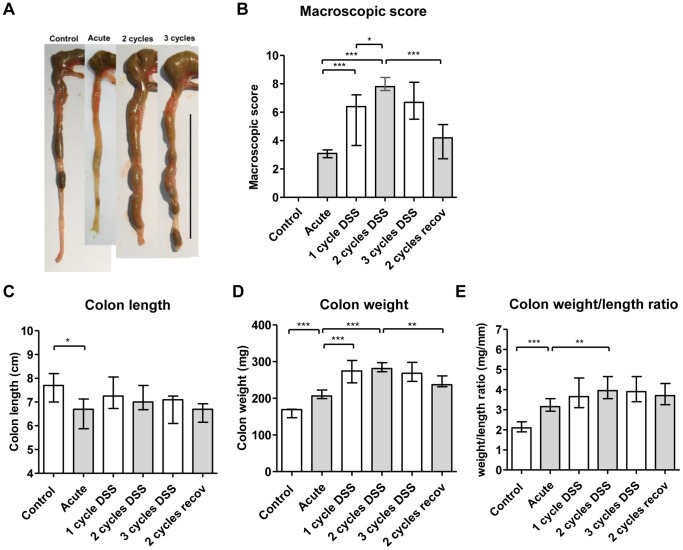
Inflammation of the colon.(A) Representative pictures of the colon in control mice, acute, 2-, and 3-cycles DSS colitis mice. The black bar represents 5 cm. (B) Macroscopic damage score of the colon in the 6 groups. (C) Length of colon shortened significant after 7 days of DSS (acute DSS colitis) compared to the control mice. (D) Weight of colon after removal of the feces. (E) Weight/length ratio of the colon. All data are expressed as medians with IQR. Mann-Whitney U testing (*p<0.05, **p≤0.01, ***p≤0.001).